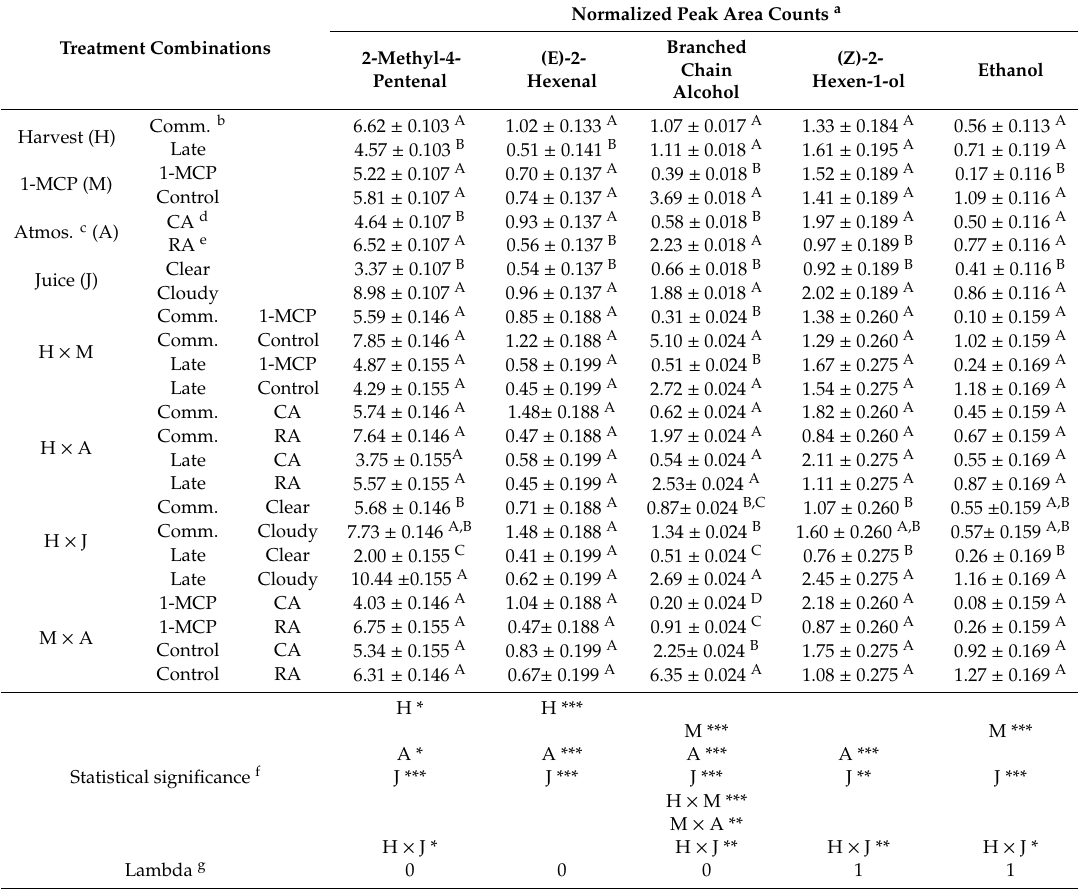
All the values represent mean ± standard error of three biological replicates. Means followed by the same letter within a column are not significantly di ff erent. a Ratio of sample peak area counts to the peak area count of the internal standard, 2-octanone. b Comm. = commercial maturity for long-term storage. c Atmos. =